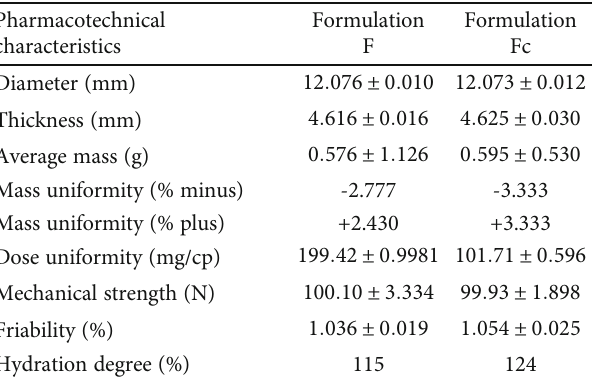
Table 8: Pharmacotechnical parameters of the matrix tablet